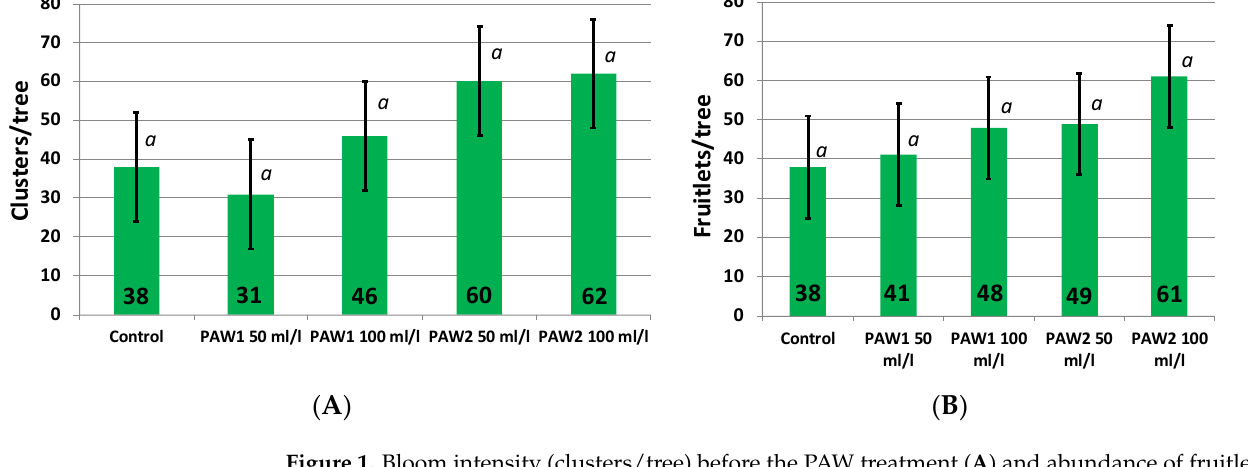
Figure 1. Bloom intensity (clusters/tree) before the PAW treatment ( A ) and abundance of fruitlets on the PAW-treated tress (after June fruitlet drop, ( B )). Average values are presented. Significantly differing values are marked with different letters. The values significantly differing, according to the Fisher’s LSD criterion (see Section 3), are marked with different letters.